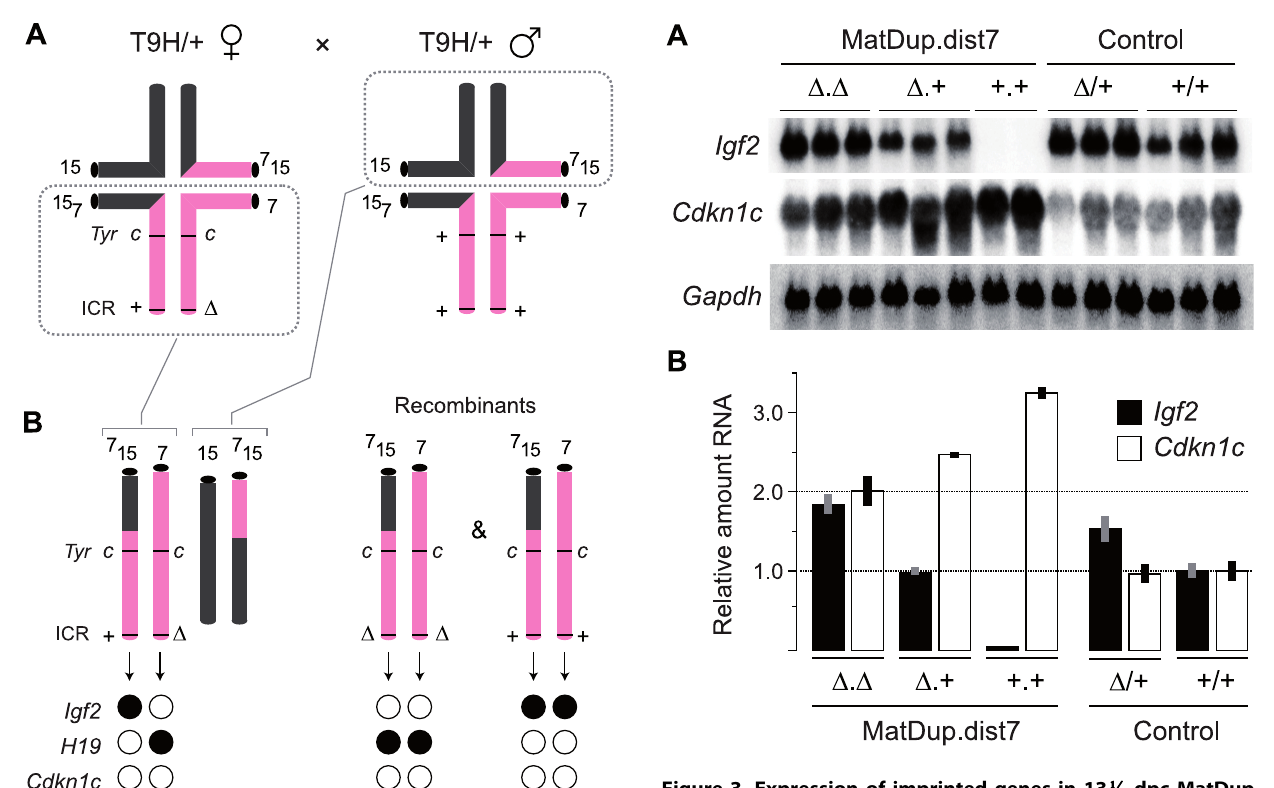
Figure 3. Expression of imprinted genes in 13 K dpc MatDup. dist7 fetuses. (A) Northern blots for the imprinted genes Igf2 and Cdkn1c , and for the housekeeping Gapdh gene for normalization. Each lane is an individual fetus. ICR genotype is given immediately above the lanes. (B) Northern blots in (A) were quantitated to show relative RNA levels. Values for Igf2 and Cdkn1c were normalized to Gapdh RNA, calibrated to control ICR + / + values, and adjusted to a mean of 1.0. Values are mean 6 s.d. with (n) as shown in (A). Mating scheme to breed these animals was as described in the legend to Figure 2.